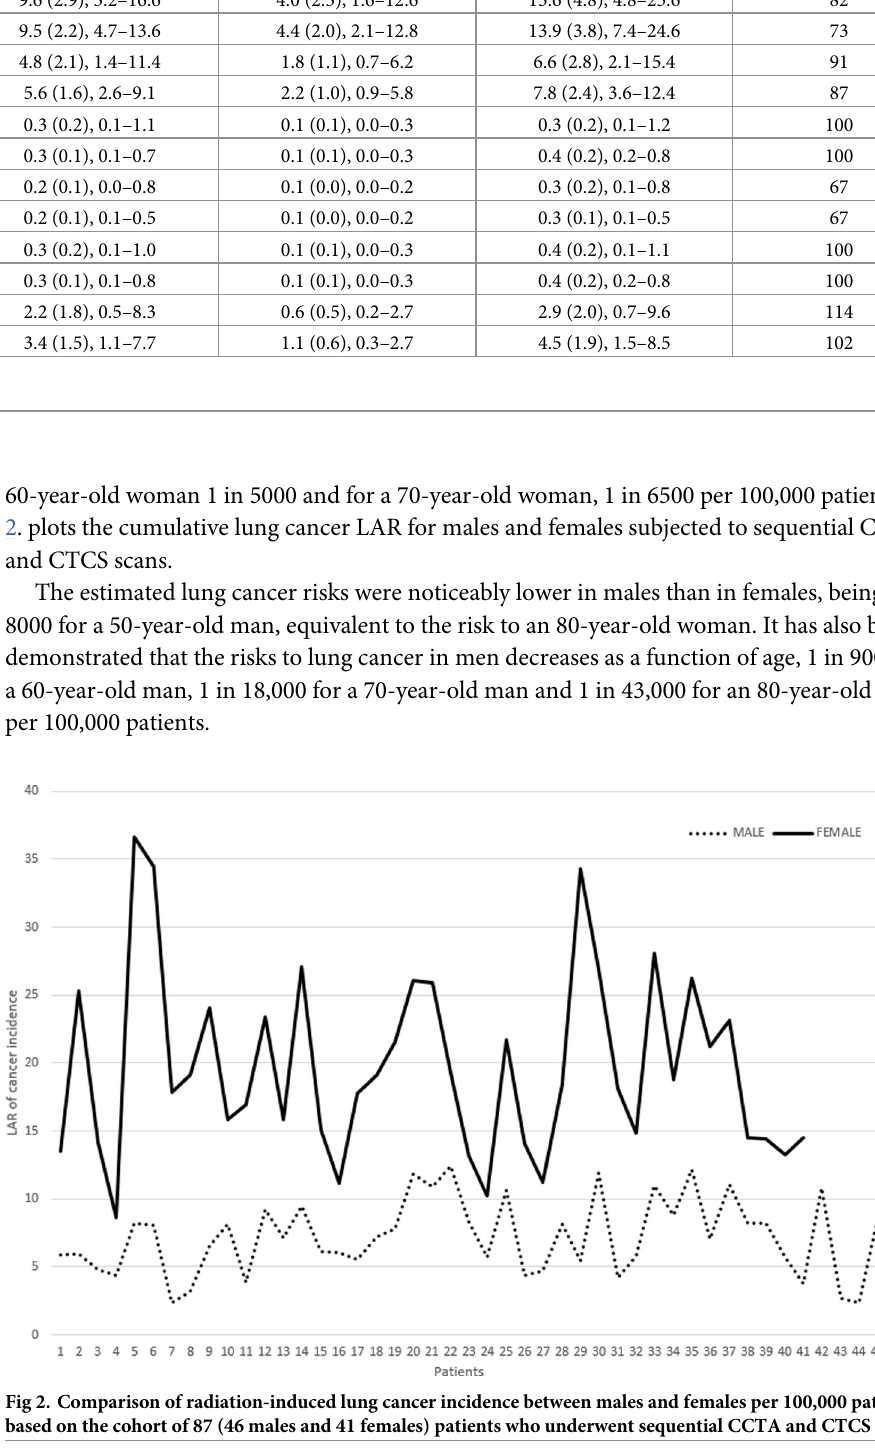
Fig 2. Comparison of radiation-induced lung cancer incidence between males and females per 100,000 patients, based on the cohort of 87 (46 males and 41 females) patients who underwent sequential CCTA and CTCS scans.